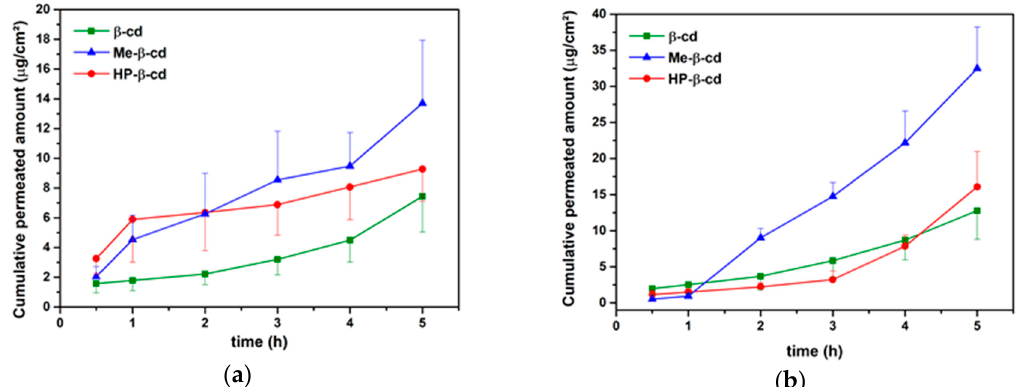
Figure 6. Cumulative transport of piroxicam across buccal mucosa ( a ) in free complexes and ( b ) in